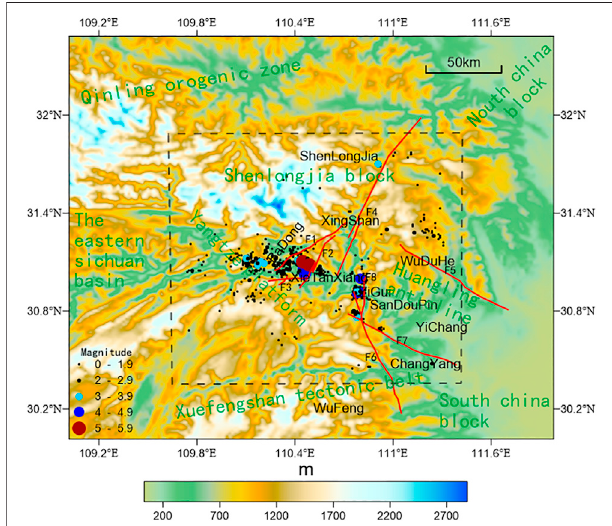
FIGURE 2 | Digital elevation model, location of major earthquakes, and faultdistribution in the Badong – Zigui and adjacentareas (F1Gaoqiaofault, F2 Niukou – Zhoujiashan fault, F3 Maluchi fault, F4 Xinhua – Shuitianba fault, F5 Wuduhe break, F6 Xiannvshan fault, F7 Tianyangping fault, and F8 Jiuwanxi fault).